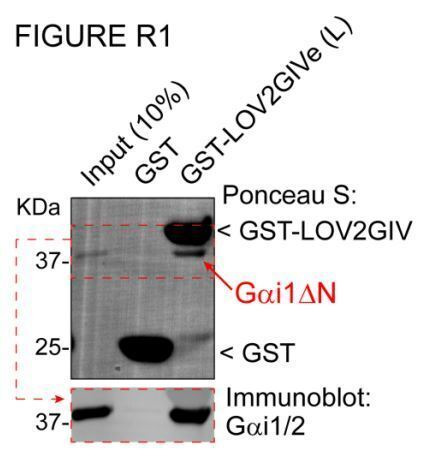
Binding of N-terminally truncated Gαi1 (Gαi1ΔN) to LOV2GIVe is detectable by Ponceau S staining.Approximately 20 µg of the indicated purified GST or GST-LOV2GVe (L) were immobilized on glutathione-agarose beads and incubated with 3 µg (~300 nM) of purified Gαi3ΔN. Resin-bound proteins were eluted, separated by SDSPAGE, and analyzed by Ponceau S-staining and immunoblotting with the Gαi1/2 antibodies. One representative result of two independent experiments is shown.